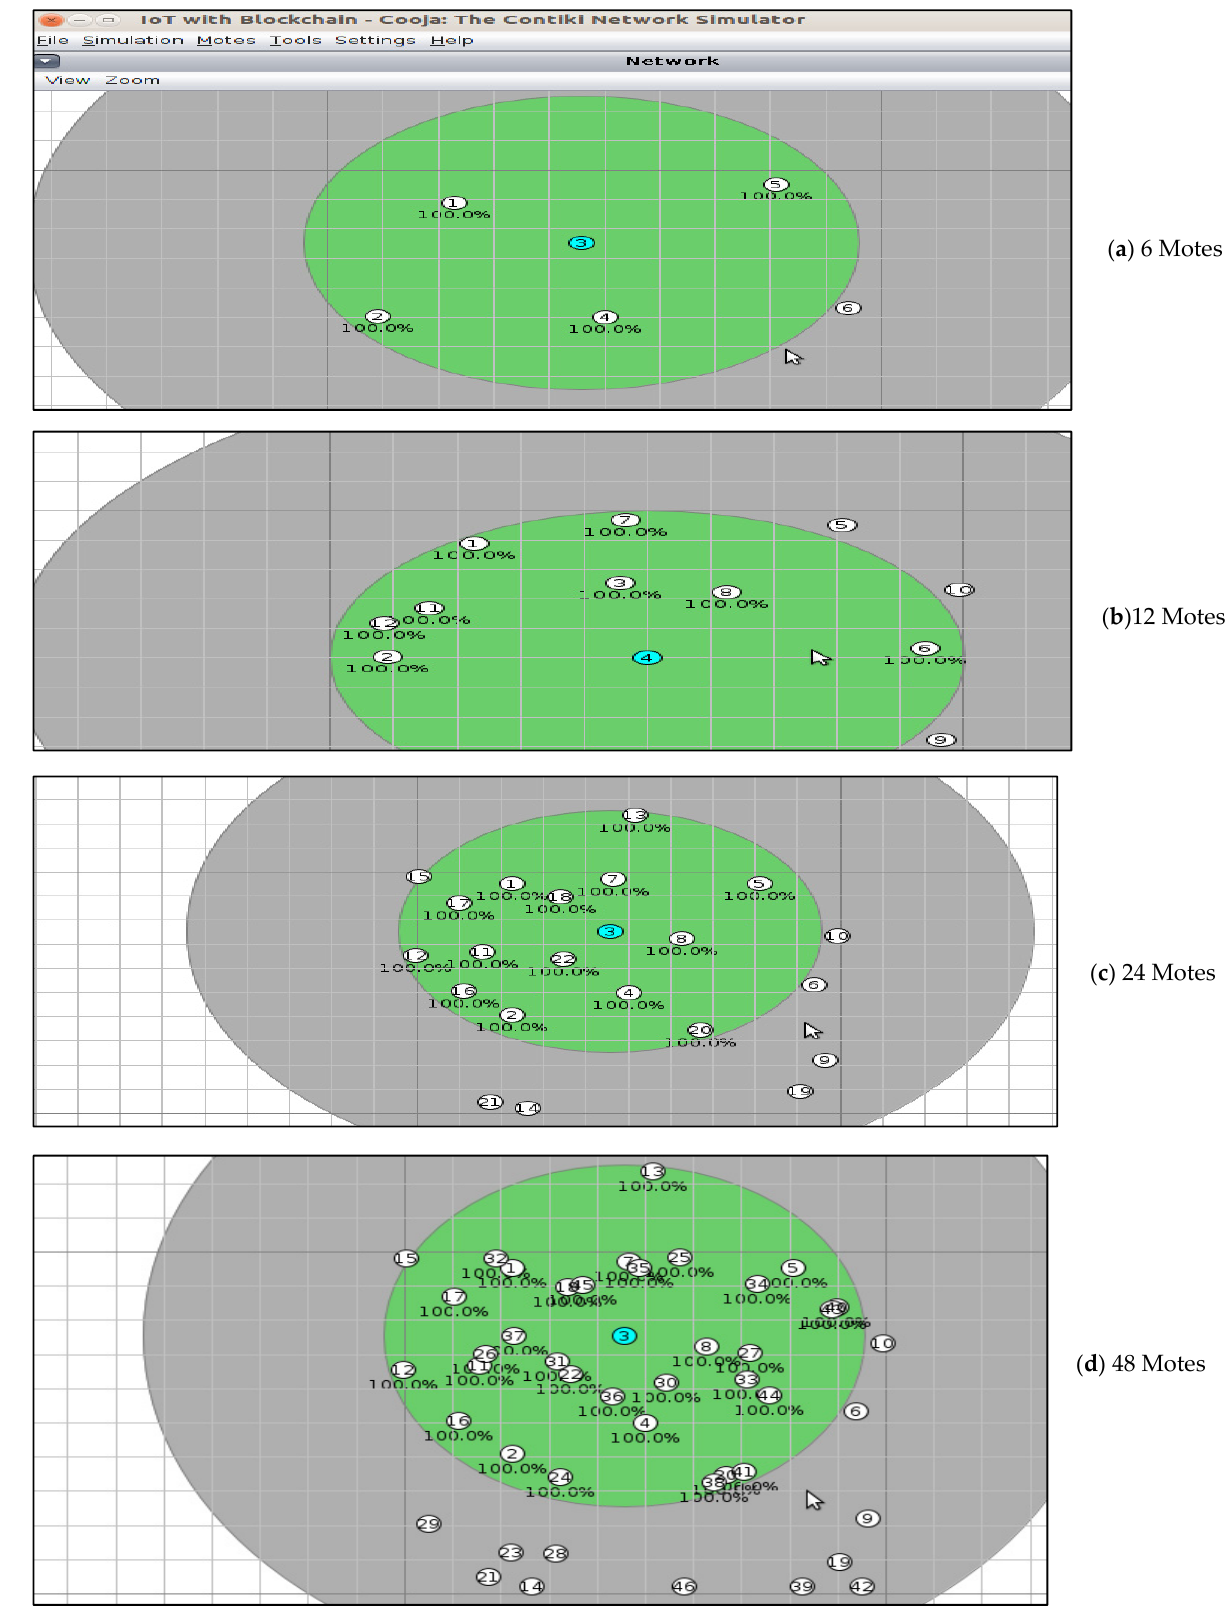
Figure 4. Networks with 6, 12, 24, and 48 Z-motes.:( a ) 6 Motes, ( b ) 12 Motes, ( c ) 24 Motes, ( d ) 48 Motes.